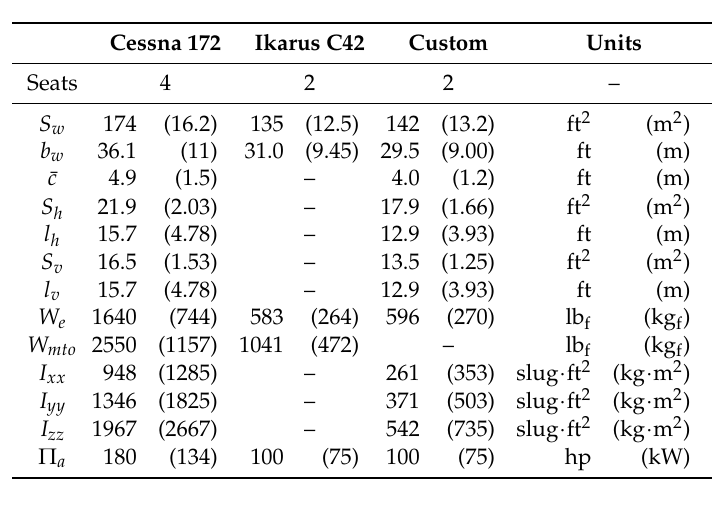
Figure 7. Comparison between the Cessna C172 Skyhawk [42] ( Left ) and the Ikarus C42 [43] ( Right ). Table 1. Main specifications of the reference aircraft and the custom version used for the simulation campaign. Geometric data is estimated via a scale factor based on S w and b w ; weights and inertia are estimated via a different scale factor based on W e and W mto .